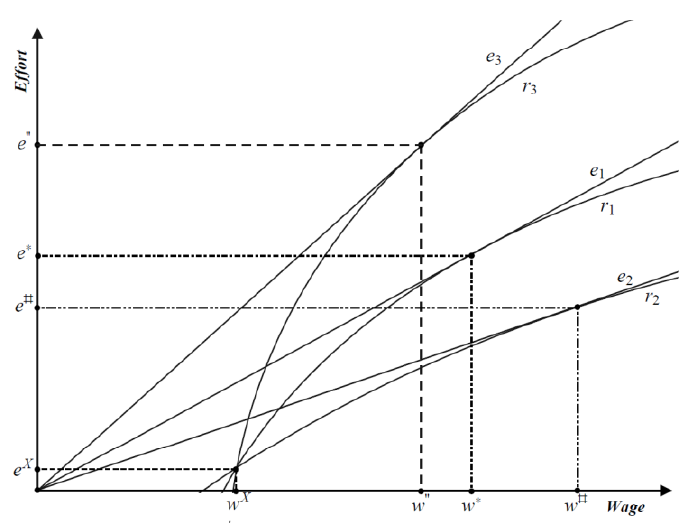
FIGURE 1: The pricing of labour in a contested market Source: Authors’ adaptation of the Stackelberg Model of Price-leadership as in Bowles and Gintis,